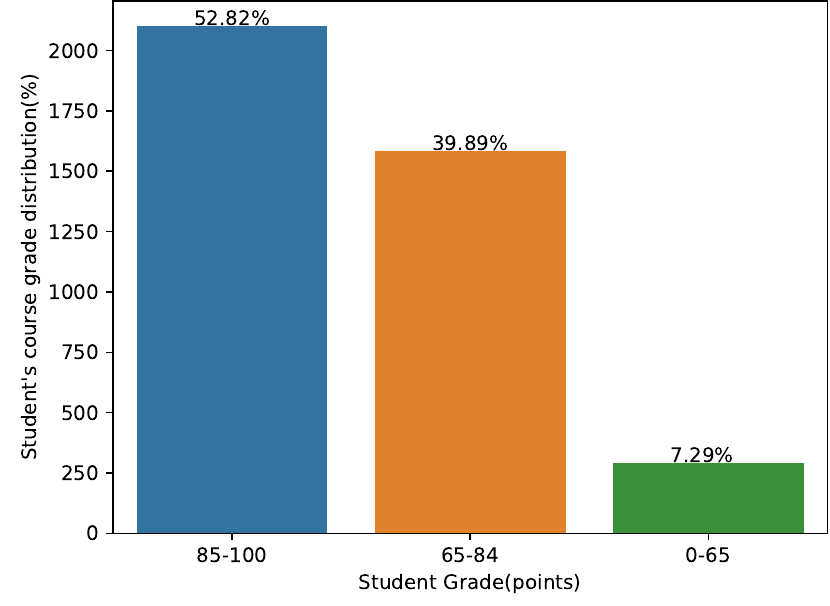
Figure 6. Proportional distribution of course